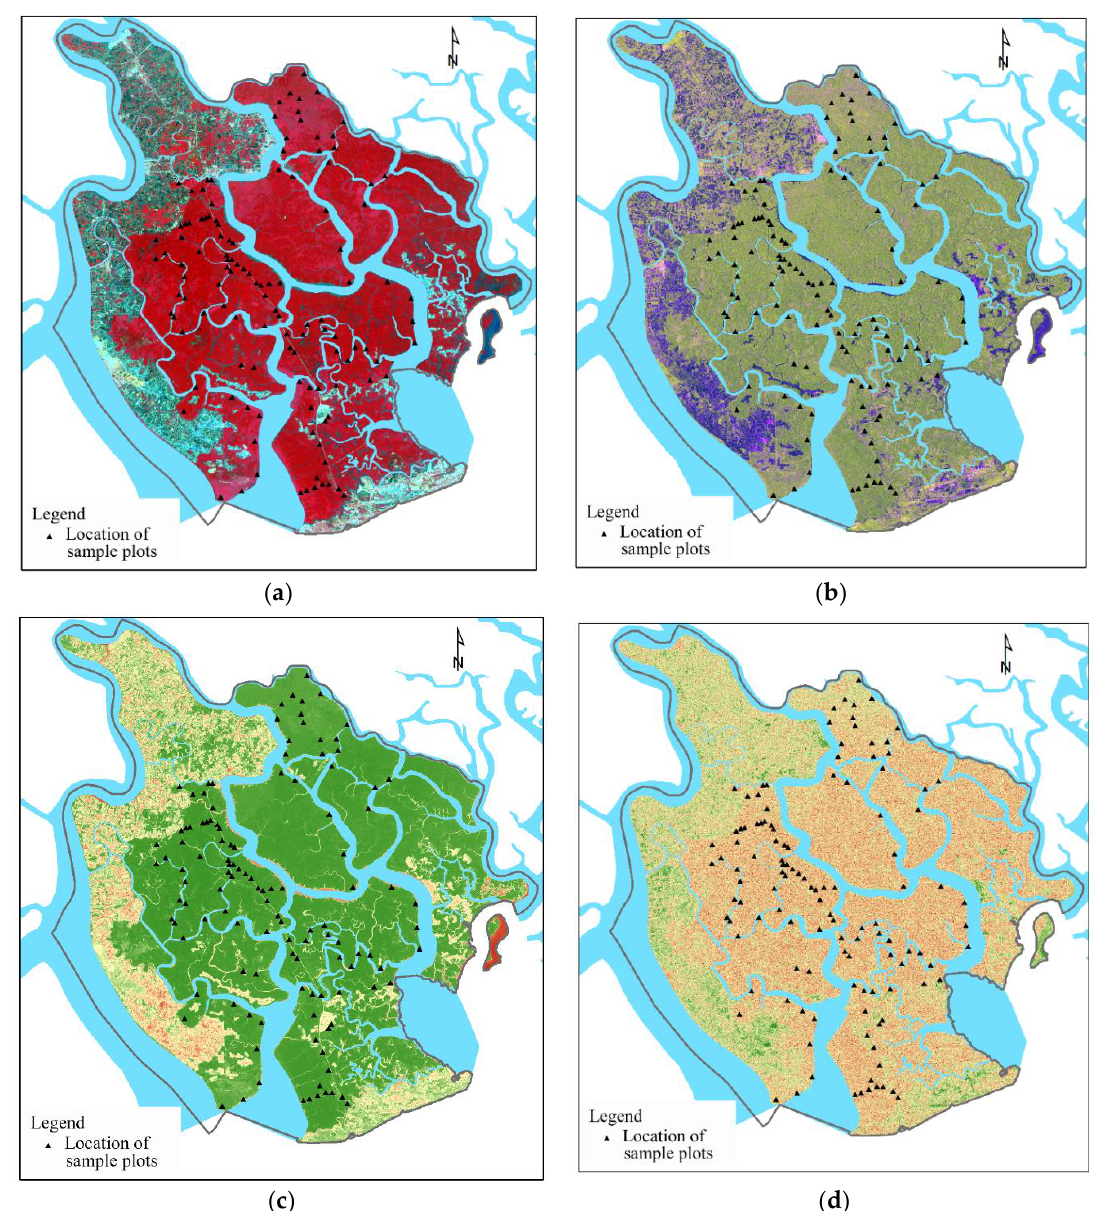
Figure 4. Illustrations of input variables in the study area. ( a ) Pseudo color composite of Sentinel-2 (RGB: Bands 8-4-3), ( b ) Pseudo color composite of ALOS-2 PALSAR-2 (RGB: HH-HV-HH / HV), ( c ) NDVI, ( d ) SAR transformation (HH-HV). Table 3. List of vegetation indices used in the current study .